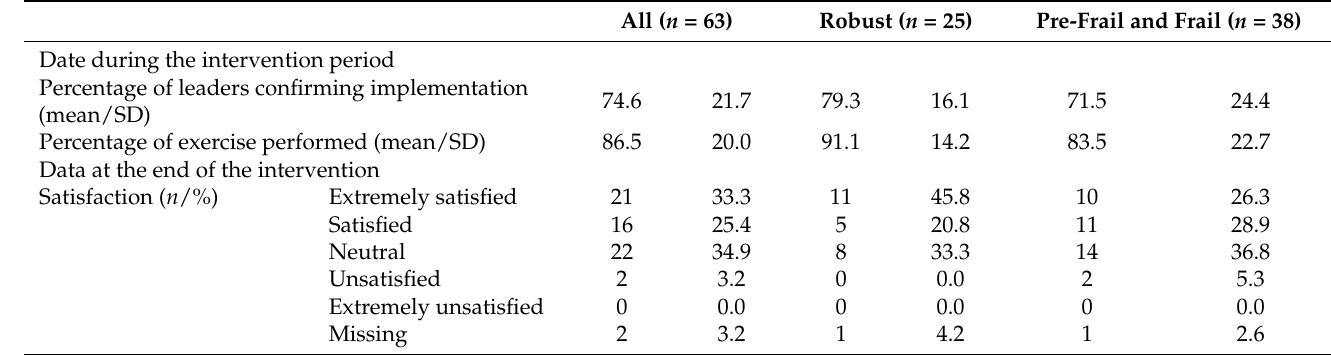
Table 4. Feasibility outcomes during the intervention and at the end of the